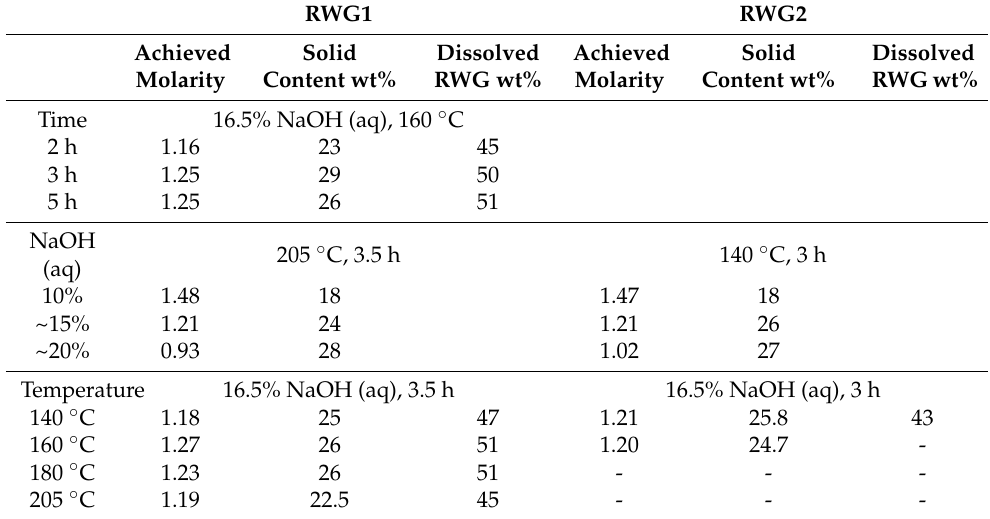
Table 2. Process conditions and resulting characteristics of the produced alkali solutions—targeted properties were SiO 2 /Na 2 O = 1.65, solid content = 35 wt%. RWG1 RWG2 Achieved Solid Dissolved Achieved Solid Dissolved Molarity Content wt% RWG wt% Molarity Content wt% RWG